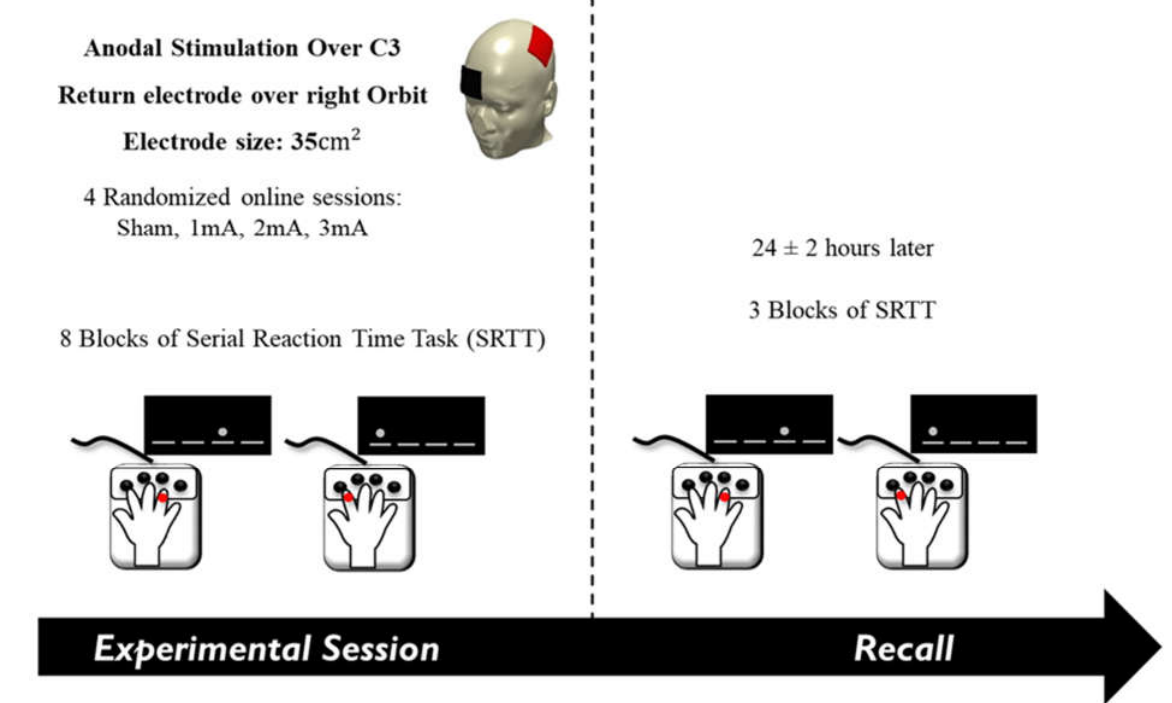
Figure 1. Course of the experiment. The anode electrode was placed over the left primary motor cortex (C3) and the cathode over the right supraorbital area. In a random order, sham, 1, 2, or 3 mA of tDCS was delivered in separate sessions while participants performed the serial reaction time task. Participants performed the recall session the following day.